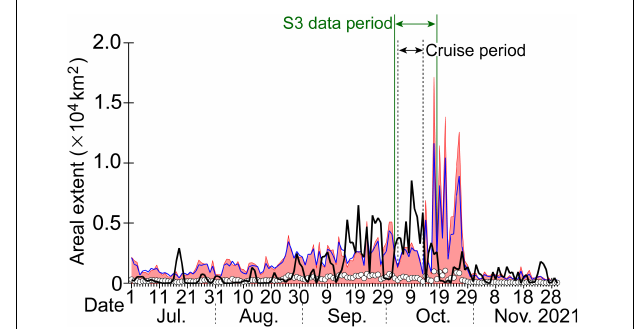
FIGURE 2 | Daily areal extent of high satellite-derived chlorophyll- a concentrations exceeding 10 mg m − 3 across the study region (i.e., within the blue dashed square in Figure 1B ). The original time series published by Kuroda et al. (2021a) was extended to 30 November, 2021. The black bold line indicates the daily areal extent in 2021. White circles denote climatological daily means calculated over the previous 23 years (1998–2020), and the blue line indicates the climatological daily mean plus three standard deviations. Red shading shows the range between the lowest daily minimums and highest daily maximums recorded over the previous 23 years. Horizontal double-headed arrows represent the periods of the ship survey (black) and the Sentinel-3 data (green) that were analyzed in this study. Chlorophyll- a concentrations were based on near-real-time and reprocessed L4 products of global daily datasets with a horizontal grid of about 4 km that were created by merging sensor data from SeaWiFS, MODIS, MERIS, VIIRS-SNPP, and JPSS1 and downloaded from the European Union’s Copernicus Marine